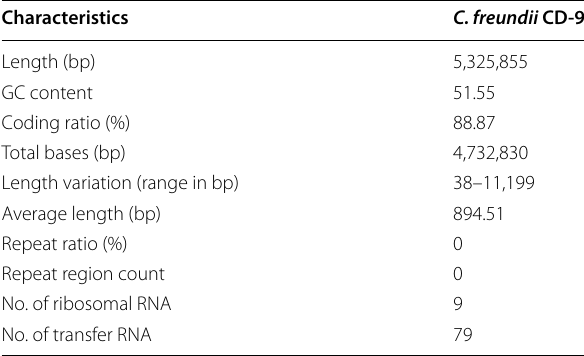
Table 3 Molecular characteristics of the genome of C.